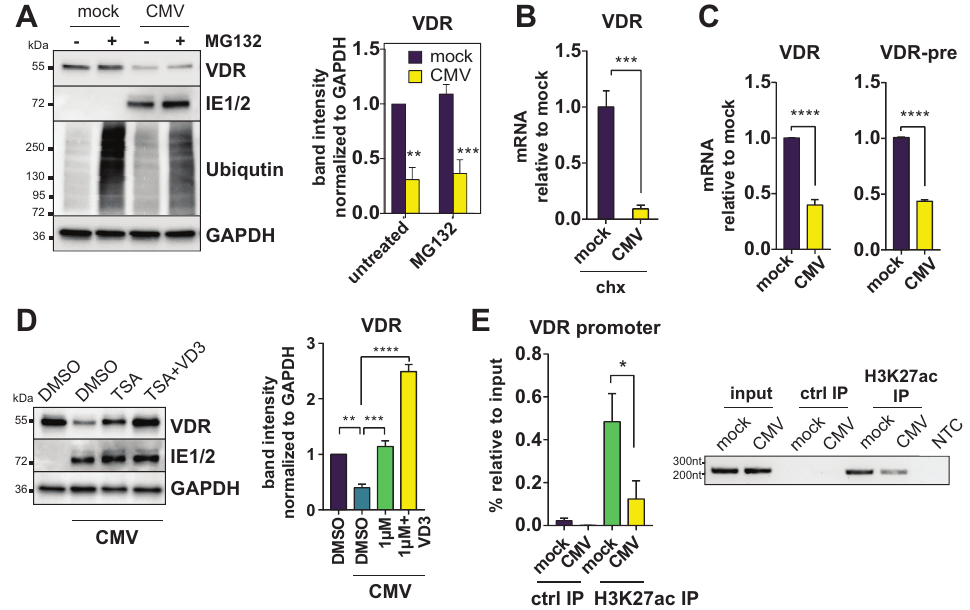
Figure 1. The VDR is epigenetically repressed during HCMV infection. ( A ) Immunoblot showing VDR and GAPDH expression in HFF treated with DMSO ( − ) or 1 µ M MG132 (+) proteasome inhibitor in mock- or CMV-infected cells. Ubiquitinated proteins are shown as a control for proteasome inhibitor effectiveness. Representative blot (left) and bar graph from multiple experiments (right panel). ( B ) RT-qPCR analysis of VDR mRNA expression in mock- or CMV-infected HFF treated with 50 µ g/mL cycloheximide (chx, n = 2) starting at 6 h p.i. and harvested 24 h p.i. Asterisks indicate significant differences to the mock control sample (unpaired Student’s t test). ( C ) RT-qPCR analysis of VDR and intron-containing unspliced pre-mRNA (VDR-pre) expression in mock- and HCMV-infected HFF harvested 24 h p.i. Asterisks indicate significant differences to the mock control sample using unpaired Student’s t tests. ( D ) Immunoblots showing VDR expression compared to GAPDH loading control in HFF infected with CMV and treated with DMSO (vehicle), 1 µ M TSA, or a combination of TSA and 10 nM calcitriol (VD3), harvested 24 h p.i. A representative blot is shown on the left, the right panel shows VDR quantification from multiple experiments with significant differences to the CMV DMSO control sample as determined by ANOVA Dunnett’s multiple comparison post-hoc test. ( E ) Purified chromatin from mock- and CMV-infected HFF was immunoprecipitated with an anti-H3K27ac polyclonal antibody or normal goat serum (ctrl IP). The left panel shows qPCR results from three independent experiments. On the right, VDR promoter amplicons from a Taq-PCR were separated on an agarose gel. NTC = no template